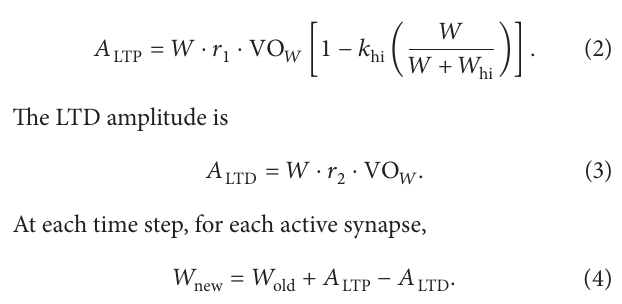
Figure 1 schematizes key elements of the model. A cluster of four spines is illustrated; two are active. High values of